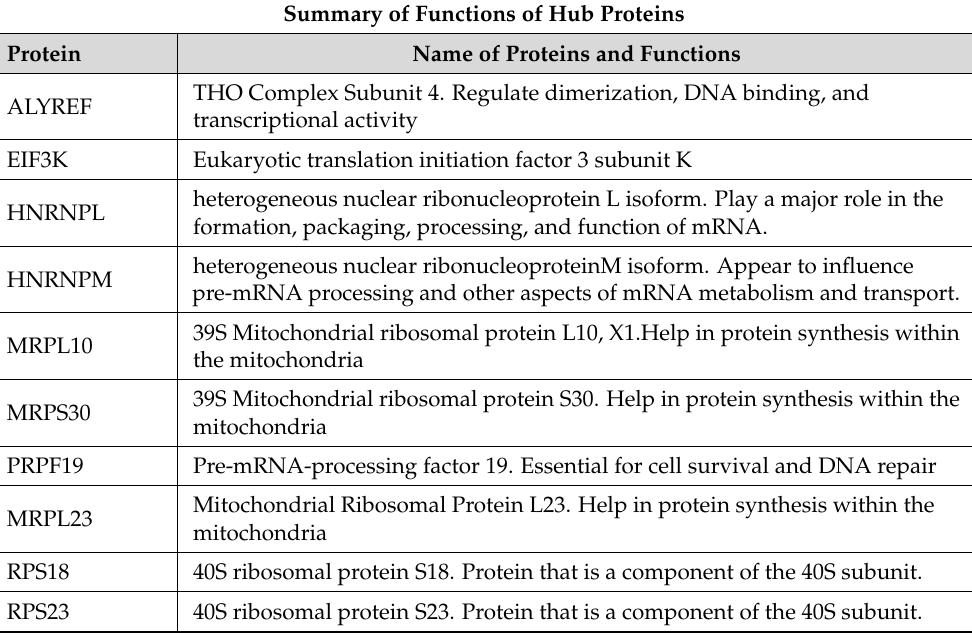
Table 5. Summary of functions of 10 overlapping proteins of Table 4.